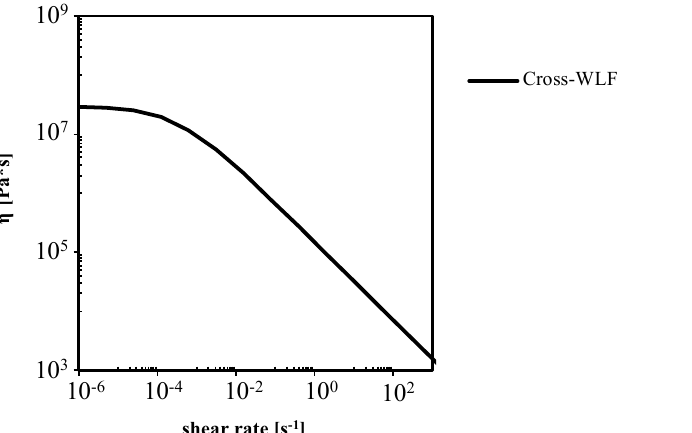
Figure 11. The T30G flow curve was calculated from the Cross-WLF model at 27 °C and in absence of crystallization.